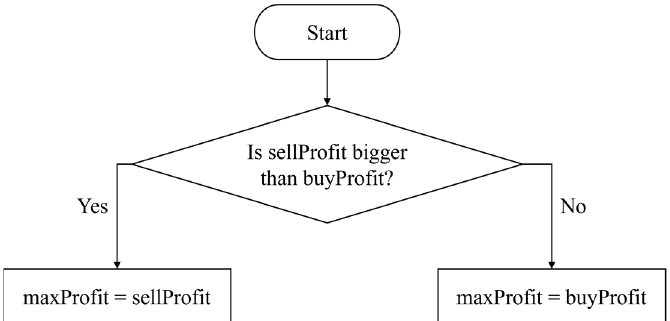
Figure 4. Flowchart of maxProfit definition.